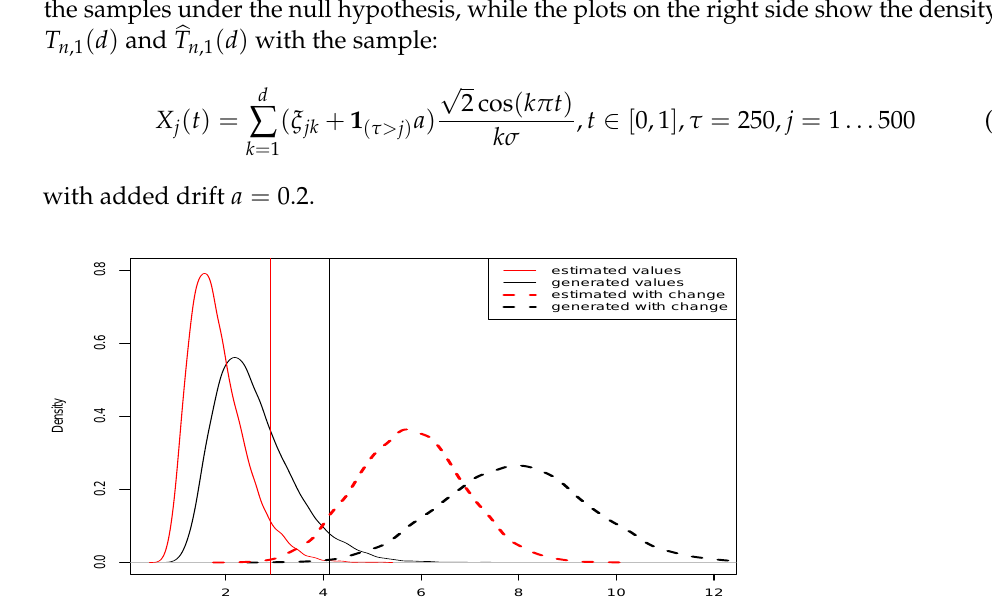
Figure 5. Density plots of the test statistic T n ,1 ( d ) and (cid:98) T n ,1 ( d ) .